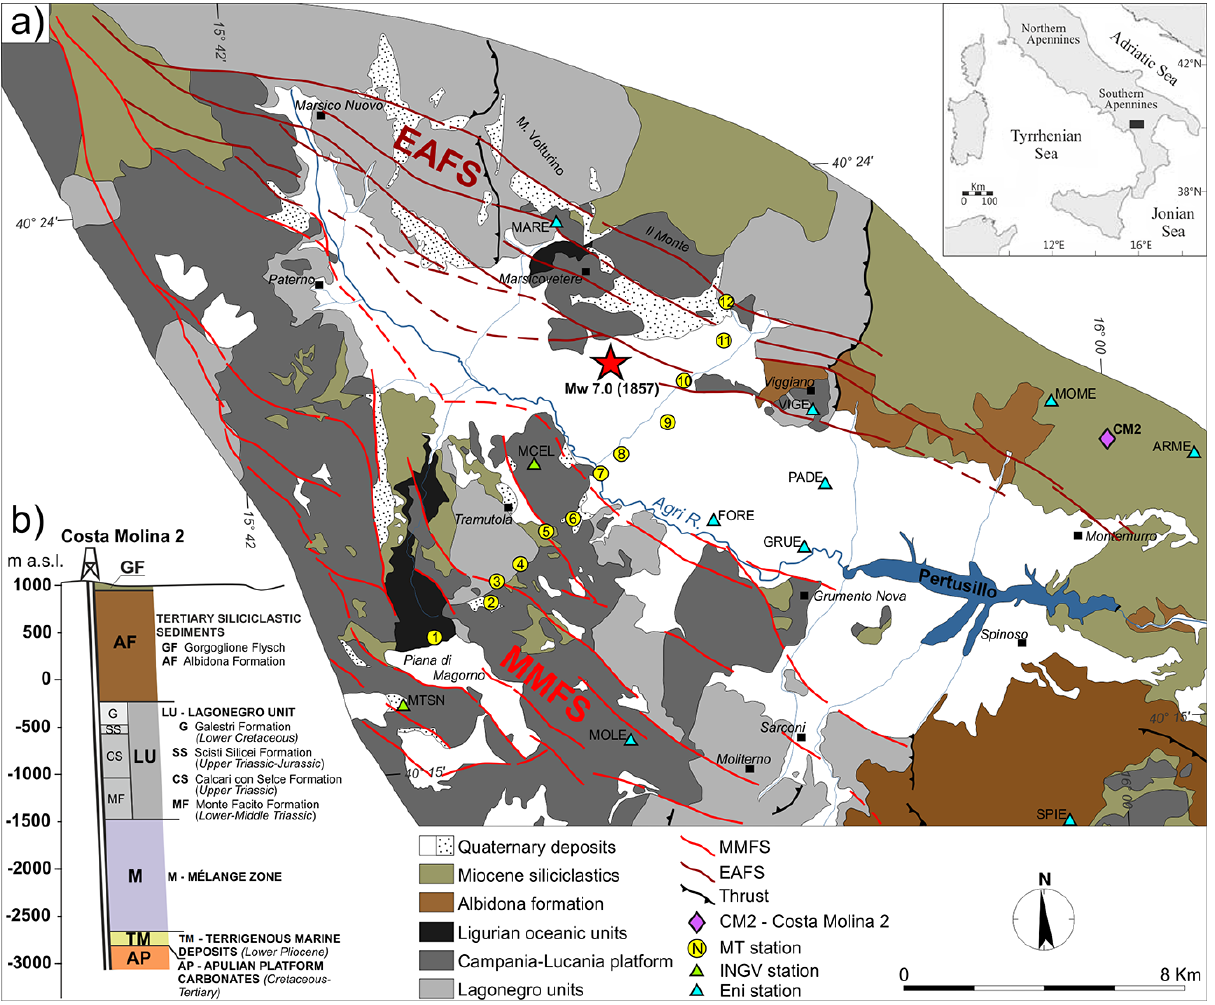
Figure 1. (a) Morphostructural map of the High Agri Valley (HAV) showing the main Quaternary fault systems and the location of the magnetotelluric soundings (modified from Giocoli et al., 2015). (b) Stratigraphic log of the Costa Molina 2 well (modified from Stabile et al.,